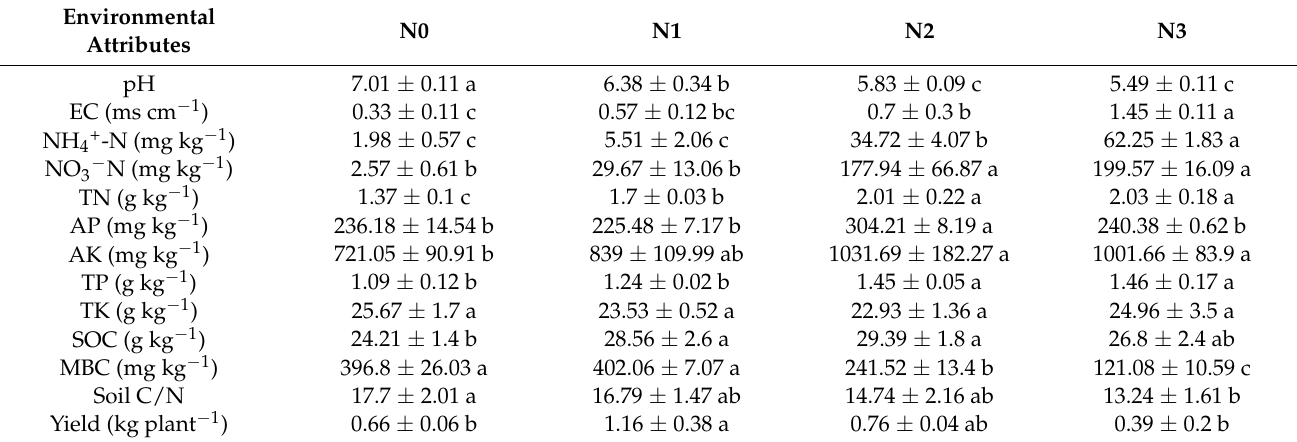
Table 2. Soil properties, microbial biomass, and cucumber yield in different N addition